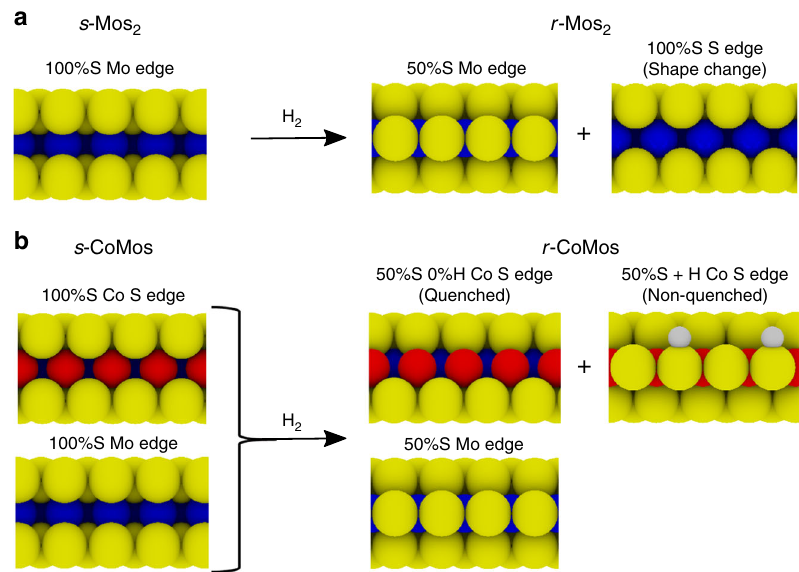
Fig. 7 Side-view ball model providing an overview of edge structures. a Non-promoted s -MoS 2 is purely 100% S Mo-edge terminated. After H 2 reduction ( r -MoS 2 ) expose both Mo-edge (50% S) and S-edge (100% S). b s -CoMoS exposes both edge types, namely 100% S Mo-edge and 100% S Co S-edge, the latter being unique to CoMoS. After H 2 reduction ( r -CoMoS), the S content of both the Mo-edge and the Co S-edge is reduced to 50%. Some of the new, reduced 50% Co S-edges contains S – H groups (non-quenched), whereas others do not (quenched)